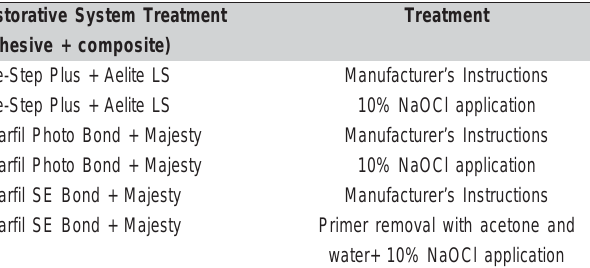
Table 2. Experimental groups and application technique for adhesive systems.